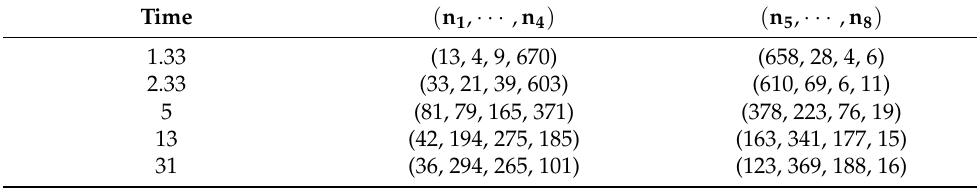
Table 4. The table provides the response frequencies from experiment 3 in [25] for each temporal